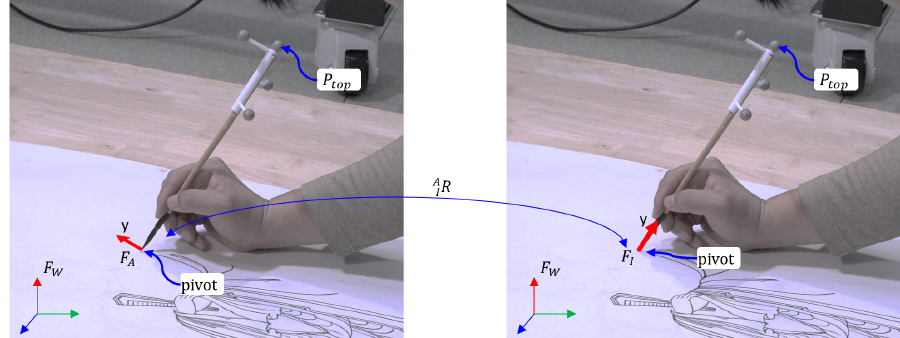
Figure 12. Relationship among the coordinate frames during painting. F W is the world coordinate system. F A is the model coordinate frame created by setting the initial pose of the brush when it is in an arbitrary pose. F I is the ideal model coordinate frame created by setting the initial pose of the brush when it stands upright; therefore, the y-axis of F I always passes through the brush